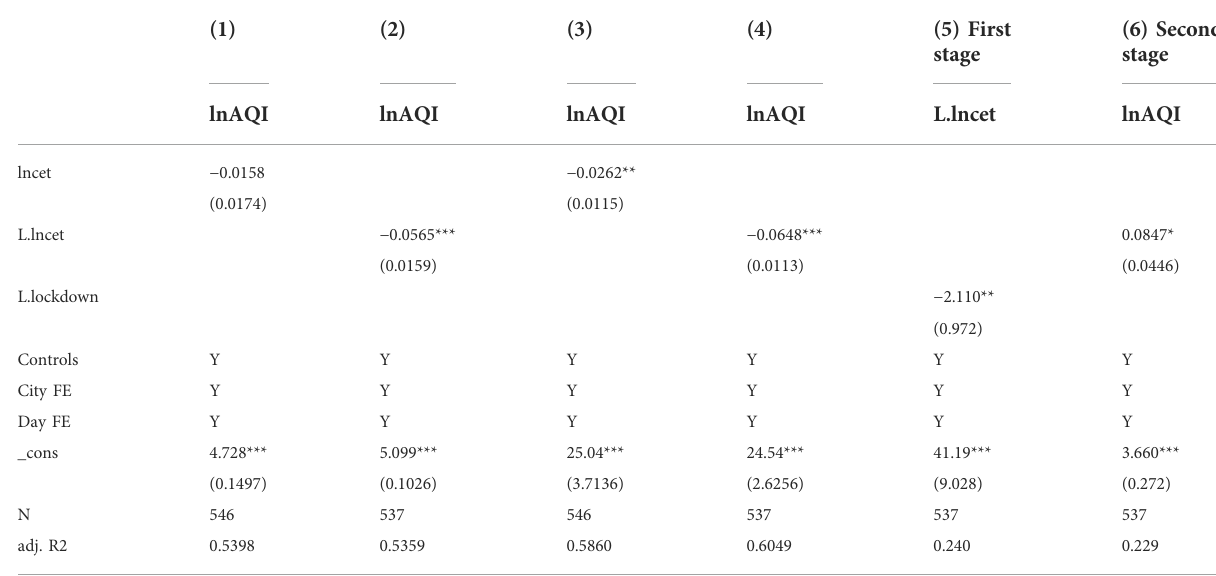
TABLE 4 Baseline regression